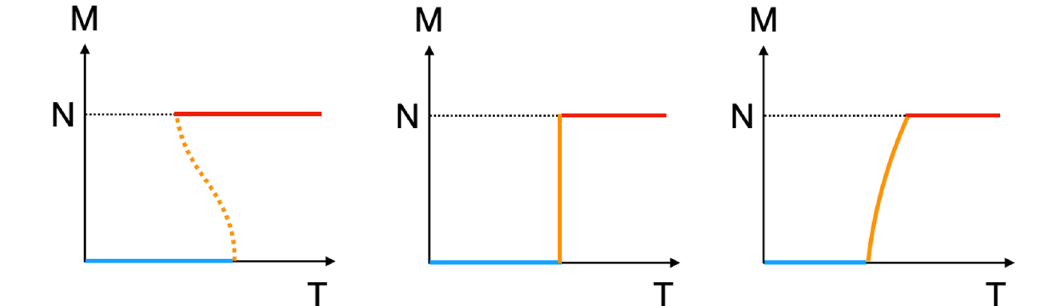
Figure 4. Three basic patterns of T -dependence of M [3]. The blue, orange and red lines are the completely confined, partially-deconfined and completely deconfined phases, respectively. [Left] First-order transition with hysteresis, e.g. strongly coupled 4d N = 4 super Yang-Mills theory on S 3 , and the Yang-Mills matrix model studied in section 4. [Middle] First-order transition without hysteresis, e.g. free Yang-Mills and Gaussian matrix model studied in section 3. [Right] Non-first- order transition, e.g. large- N QCD